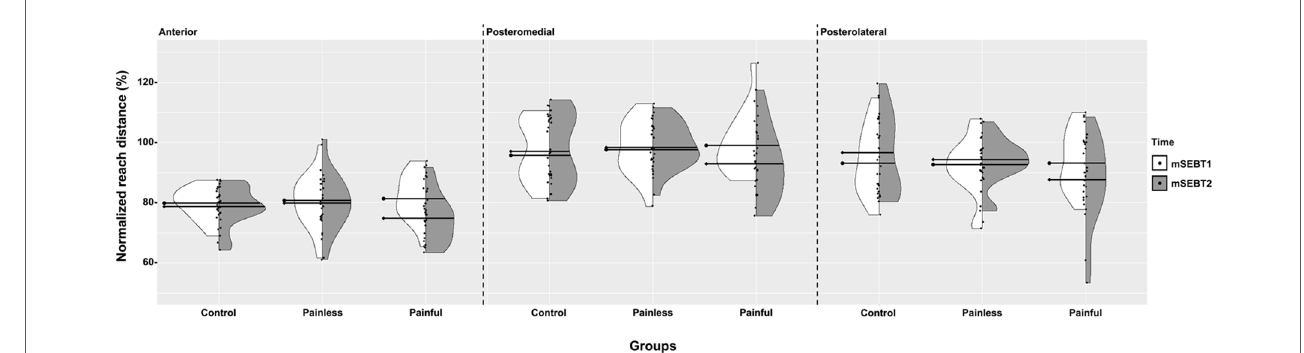
FIGURE 2 Violin plot representing mSEBT1 and mSEBT2 data. The distribution of mSEBT1 (white) and mSEBT2 (grey) data are presented for each group and for each direction. The thick black lines represent the median for each dataset ( ● - for mSEBT1 and ♦ - for mSEBT2). Each dot represents the normalized reach distance for a participant.